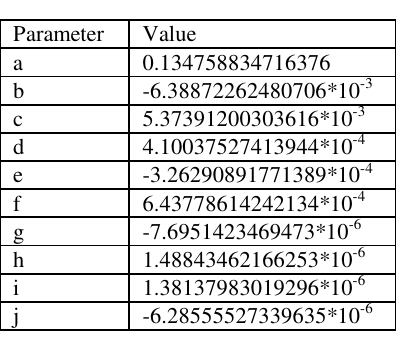
Table 2. Parameters for equation (1) DBH values calculated with this model show a standard deviation of 3.26cm when compared to the recorded DBH values.